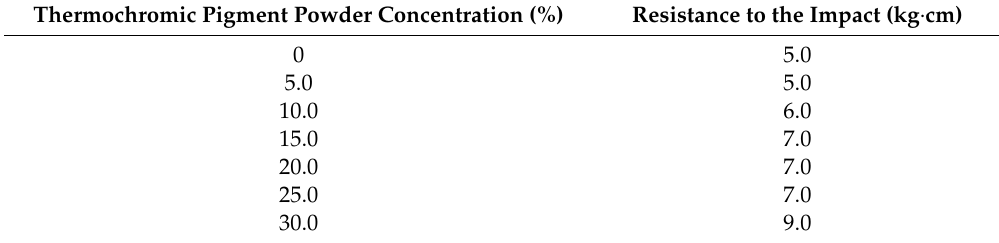
Table 6. Influence of di ff erent concentrations of the thermochromic pigment powder on the resistance to the impact of the primer